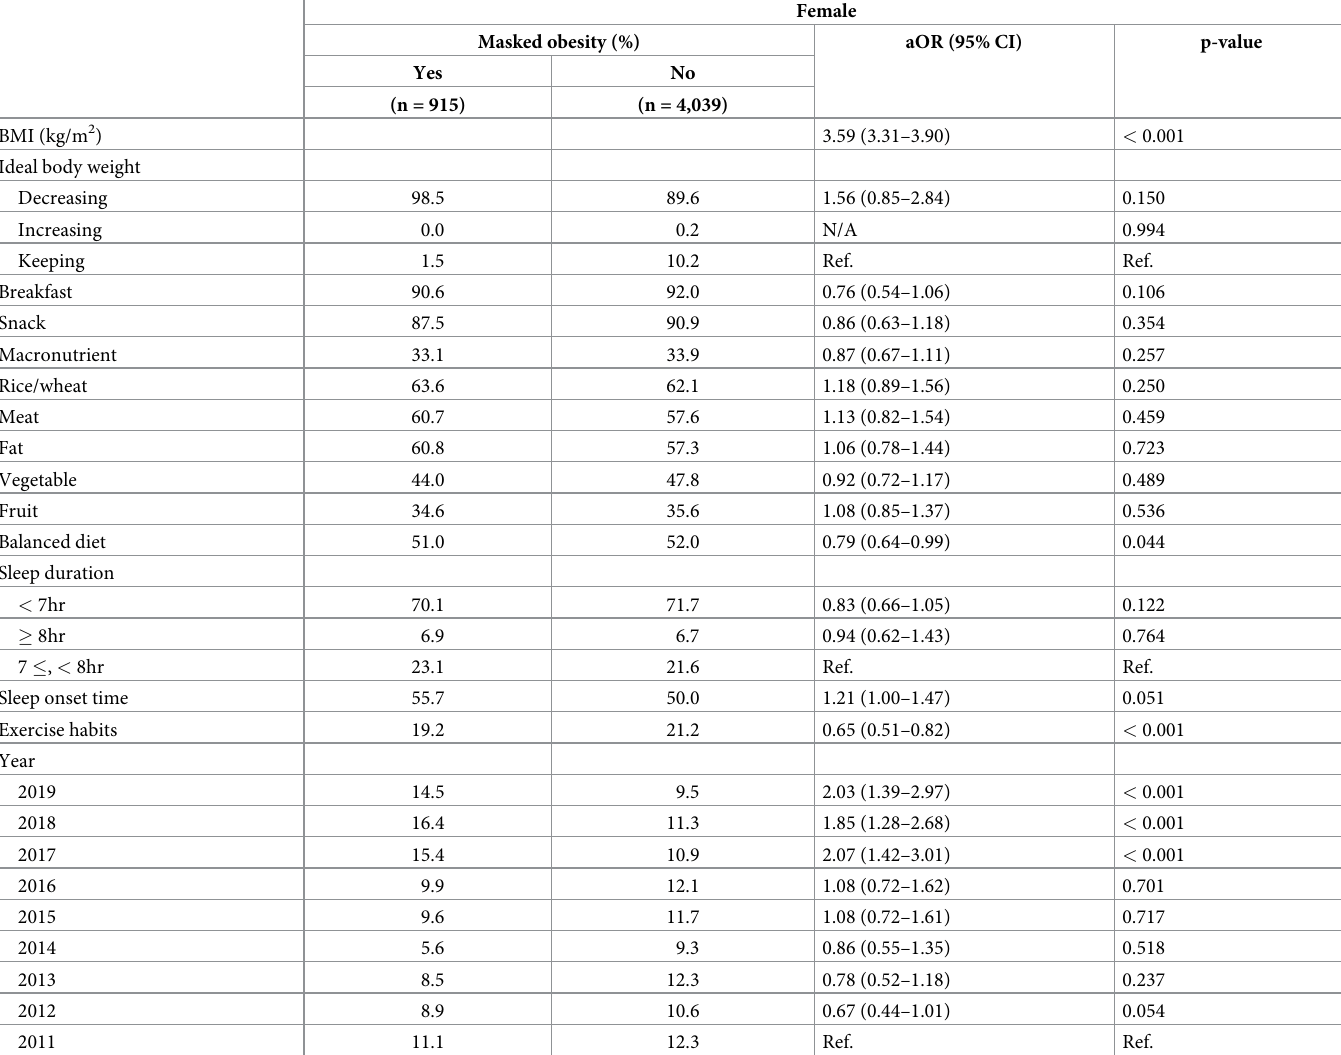
Table 4. Relationship between masked obesity and weight control orientation or lifestyle habits in female